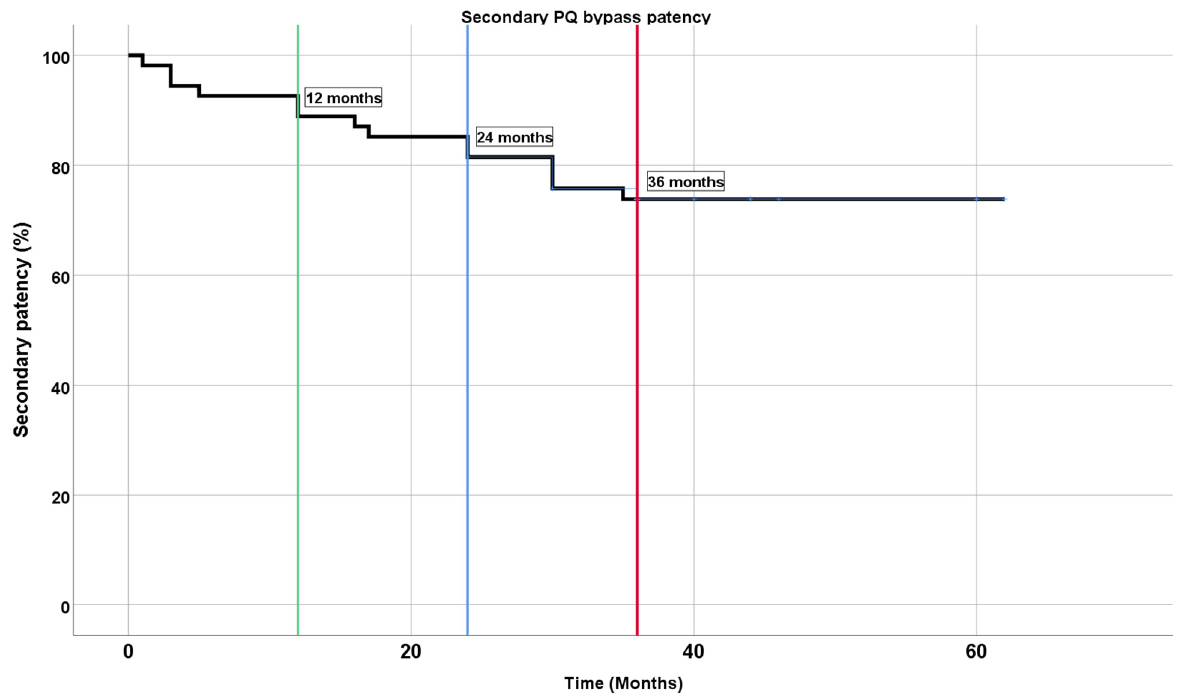
Figure 5. Kaplan–Meier plot for secondary patency at 1 year (green line), 2 years (blue line), and 3 years (red line). Table 2. Patency data summary at different time points throughout follow ‐ up period.